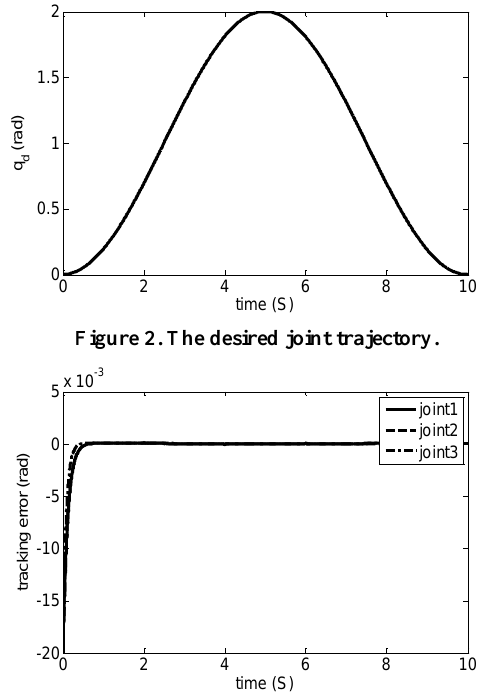
Figure 3. Performance of the proposed control.